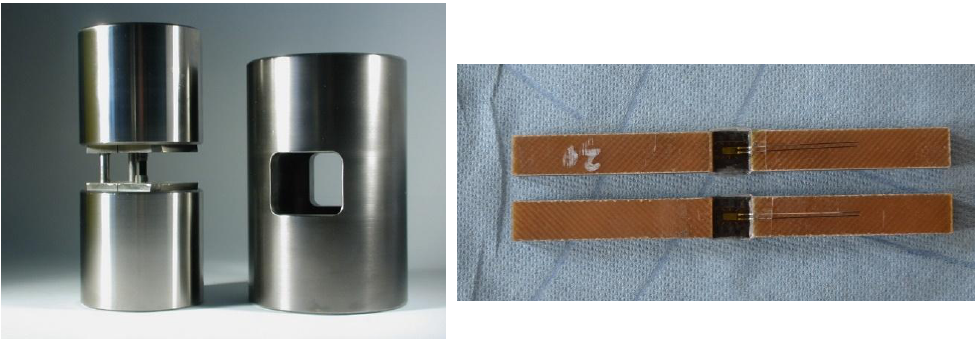
Figure 1. Pictures of Celanese test setup and sample preparation.